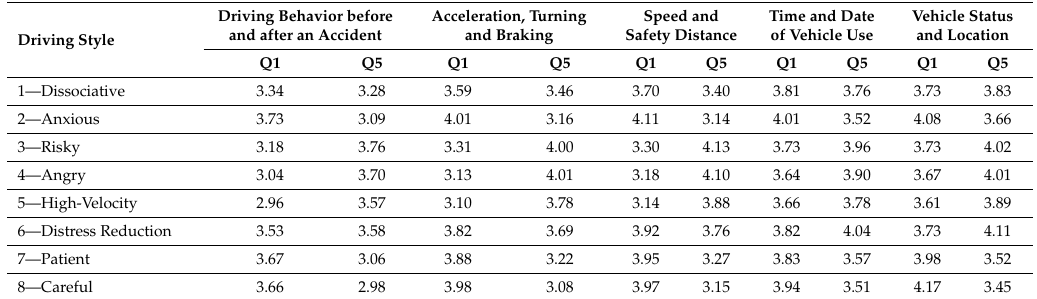
Table 10. Willingness to share by type of information and driving style quintiles